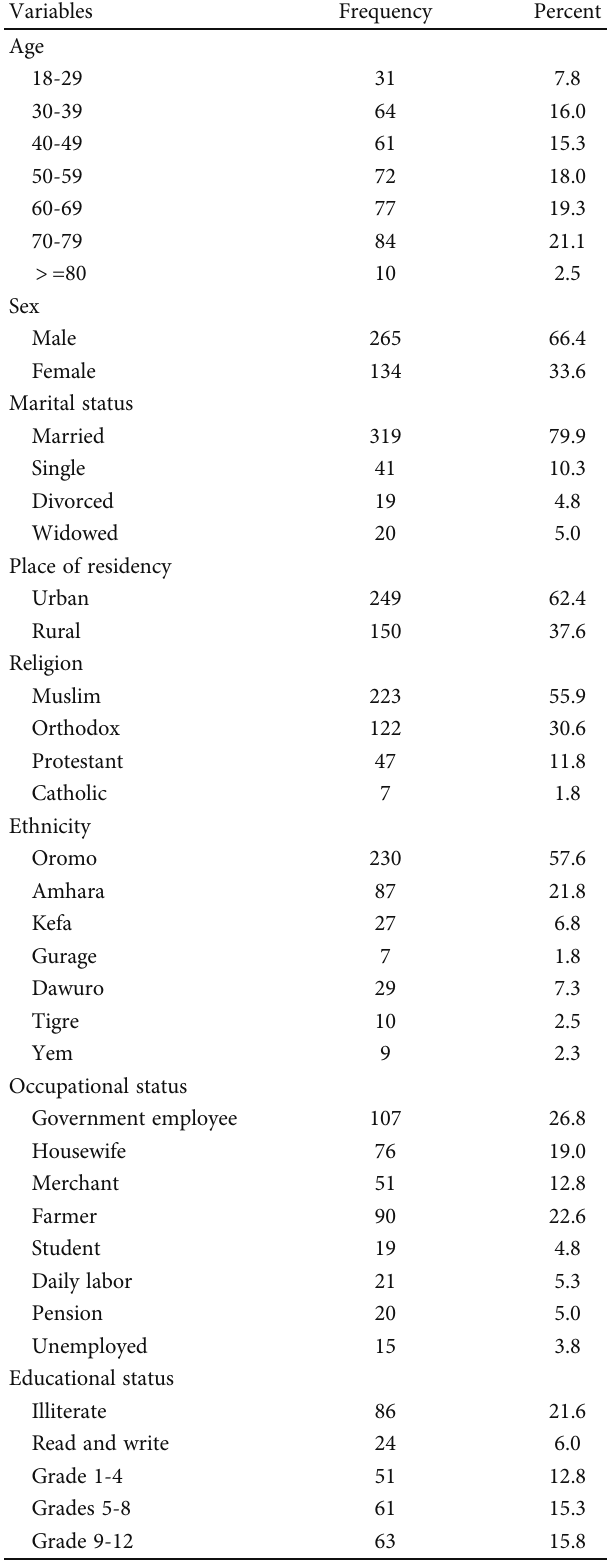
Table 1: Sociodemographic characteristics of persons with diabetes ’ perceptions of family burden and associated factors at a university hospital ( n = 399